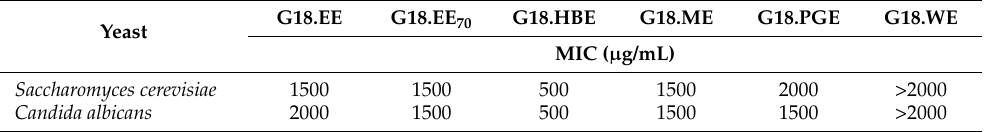
Table 3. MIC values ( µ g/mL) obtained against the two-susceptibility indicator yeasts. Mid- exponential phase microbial cultures were transferred to plates supplemented with increasing concentrations of each of the six extracts—G18.EE, G18.EE 70 , G18.HBE, G18.ME, G18.PGE and G18.WE. Plates were observed for the presence/absence of growth after 48 h incubation at 30 ◦ C, and the lowest concentrations for which no growth was detected were registered as the MIC values.